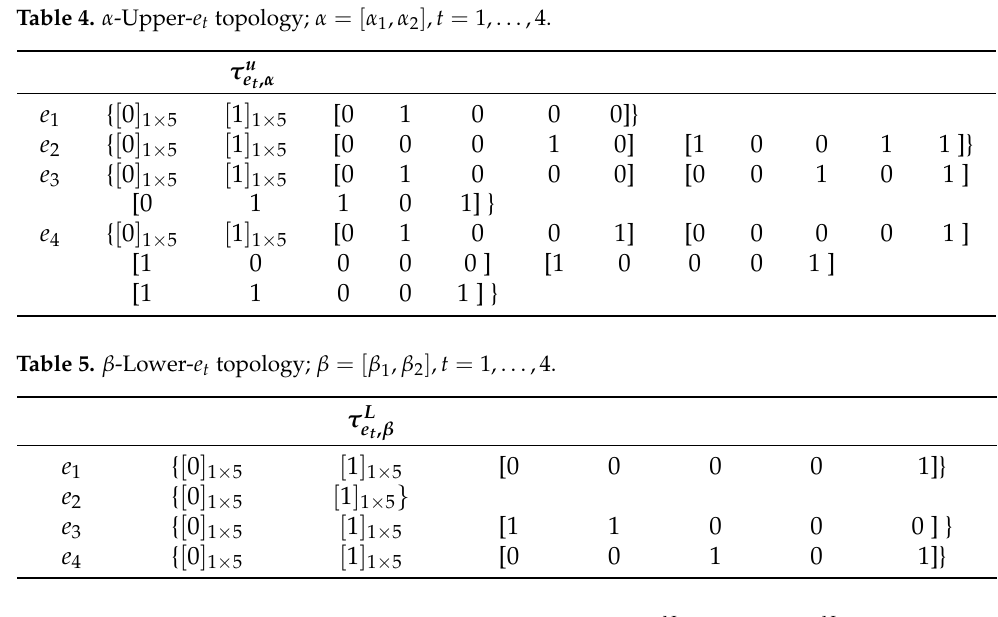
Step 5. The comparison matrices G ( e t , α ) , S ( e t , β ) , E U ( e t , α ) and E U ( e t , α ) , over X where α = [ α 1 , α 2 ] , β = [ β 1 , β 2 ] , t = 1, . . . , 4 as